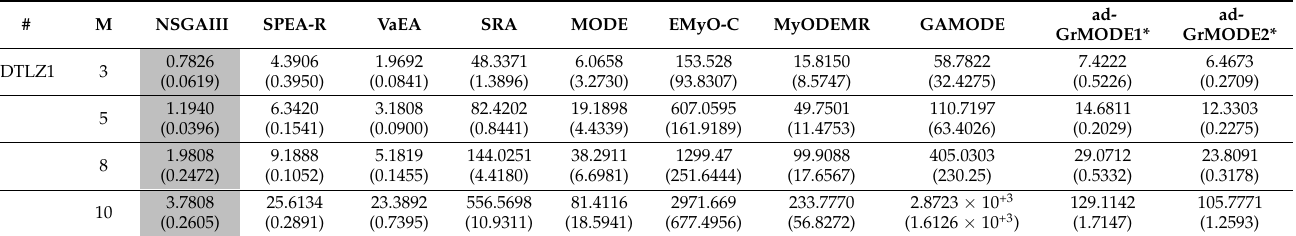
Table 5. Runtime evaluation of the proposed algorithm compared with state-of-the-art algorithms for the DTLZ1